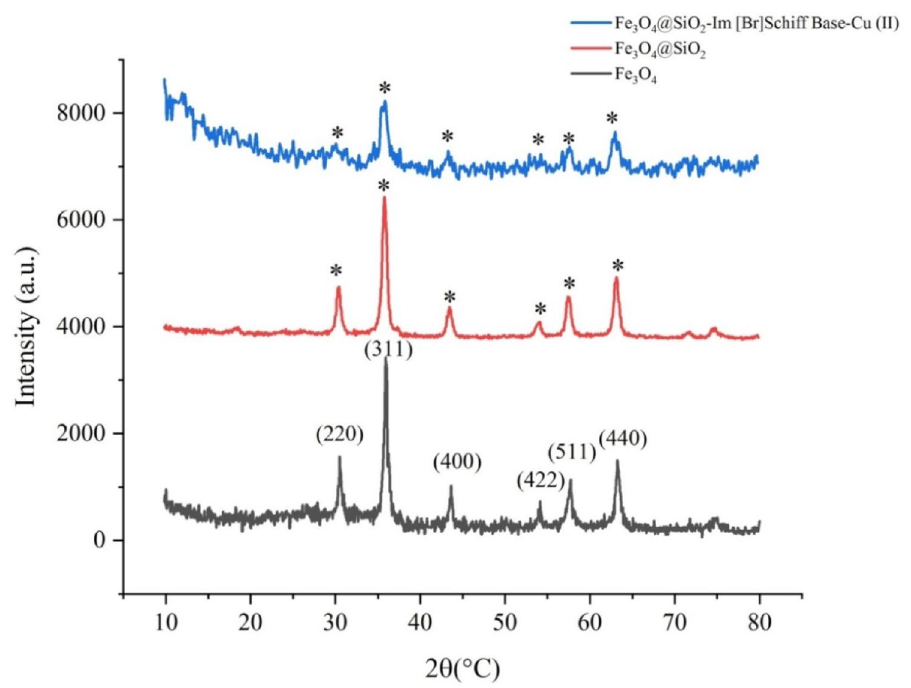
Figure 8. XRD patterns of Fe 3 O 4 , Fe 3 O 4 @SiO 2 and Fe 3 O 4 @SiO 2 -Im[Br]-SB-Cu (II) nano-catalyst.